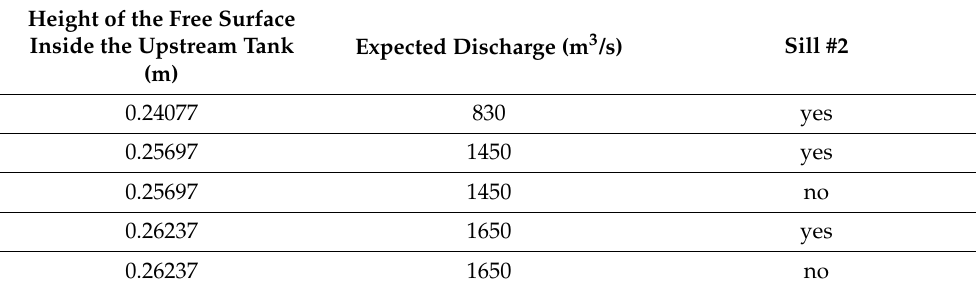
Table 5. Height of the free surface inside the upstream tank, expected flow rate and the presence of sill #2 for Model #2.